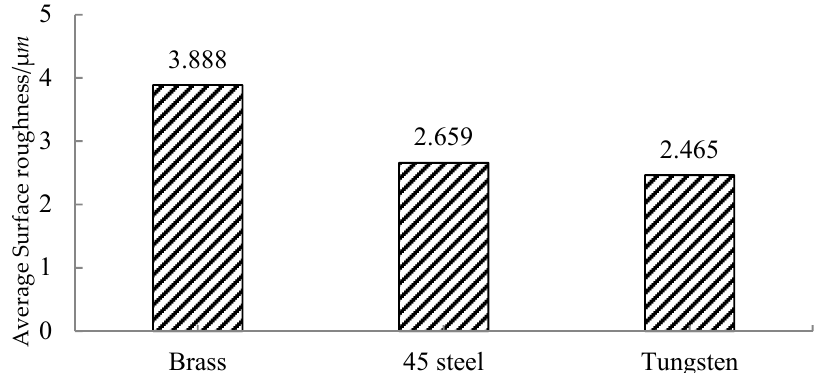
Figure 9. Comparison of surface roughness of the three materials.